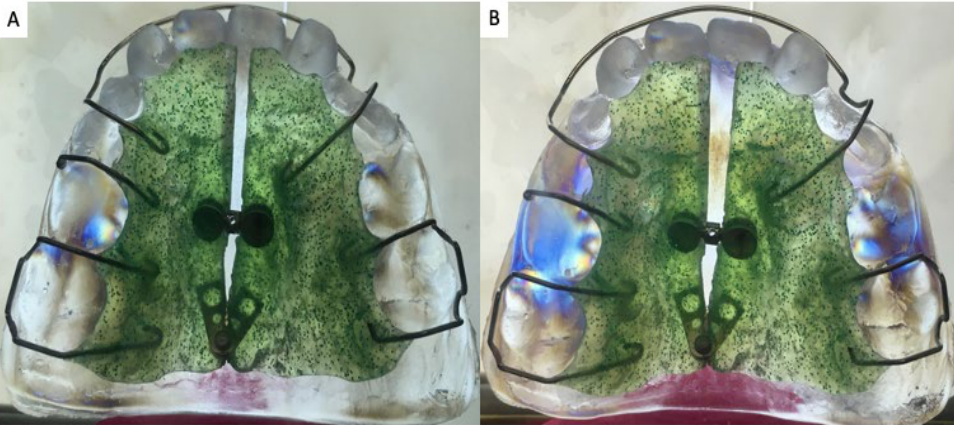
Figure 4. Example of the use of photoelasticity in dentistry with the placement of an expansion device on a photoelastic model of a patient. ( A ) Sitting of the appliance without activation of the screw; the isochromes indicate that the appliance is not passive and that stresses are already present due to (1) a poor hook design (2) an irregular vestibular archwire and (3) the presence of cavities due to caries. ( B ) After activation of the screw (observe the opening of the midline), the isochromes intensify in the areas where they were seen before and also spread towards the palate [110].